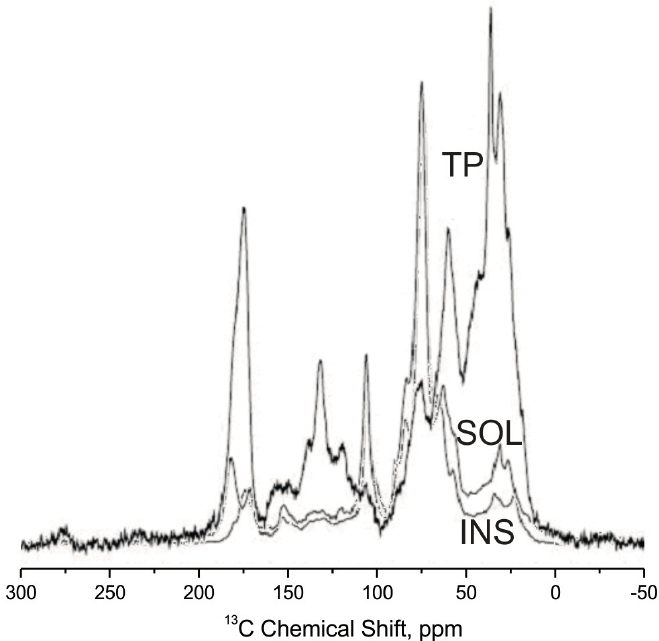
Figure 2. 13 C NMR solid state spectra of TP, SOL and